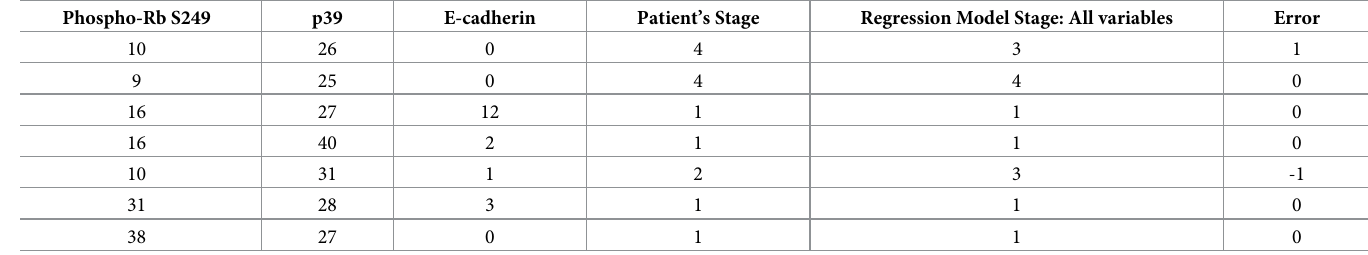
Table 9. A random sample of SCC tumors from our TMAs were selected to calculate tumor staging using our linear regression model when considering only E-cad- herin score. The tables show the score for phospho-Rb S249, p39, E-cadherin and the patient´s tumor stage ( first fourth columns , respectively ). The fifth column shows the stage predicted by our linear regression analysis the when the three scores are combined. The Error (sixth) columns in all five tables show the difference between the vendor score and our linear regression analysis score, a value of 0 indicating identical scores, while a number other than 0 means that the two scores were different by a magnitude equal to the number indicated in the column. Finally, all three scores combined accurately predicted the tumor stage in 5 out of 7 samples. A linear regression model having only linear terms can result in positive or negative predictions if no other restrictions are present. In contrast, the three scores combined were able to accurately predict tumor stage in 5 out of 7 samples, and in the two samples in which the prediction was not perfectly accurate, they overestimated tumor stage by only a magnitude of 1. This suggests that the combination of phospho-Rb S249, p39, and E-cadherin scores may have strong predictive power for assessing